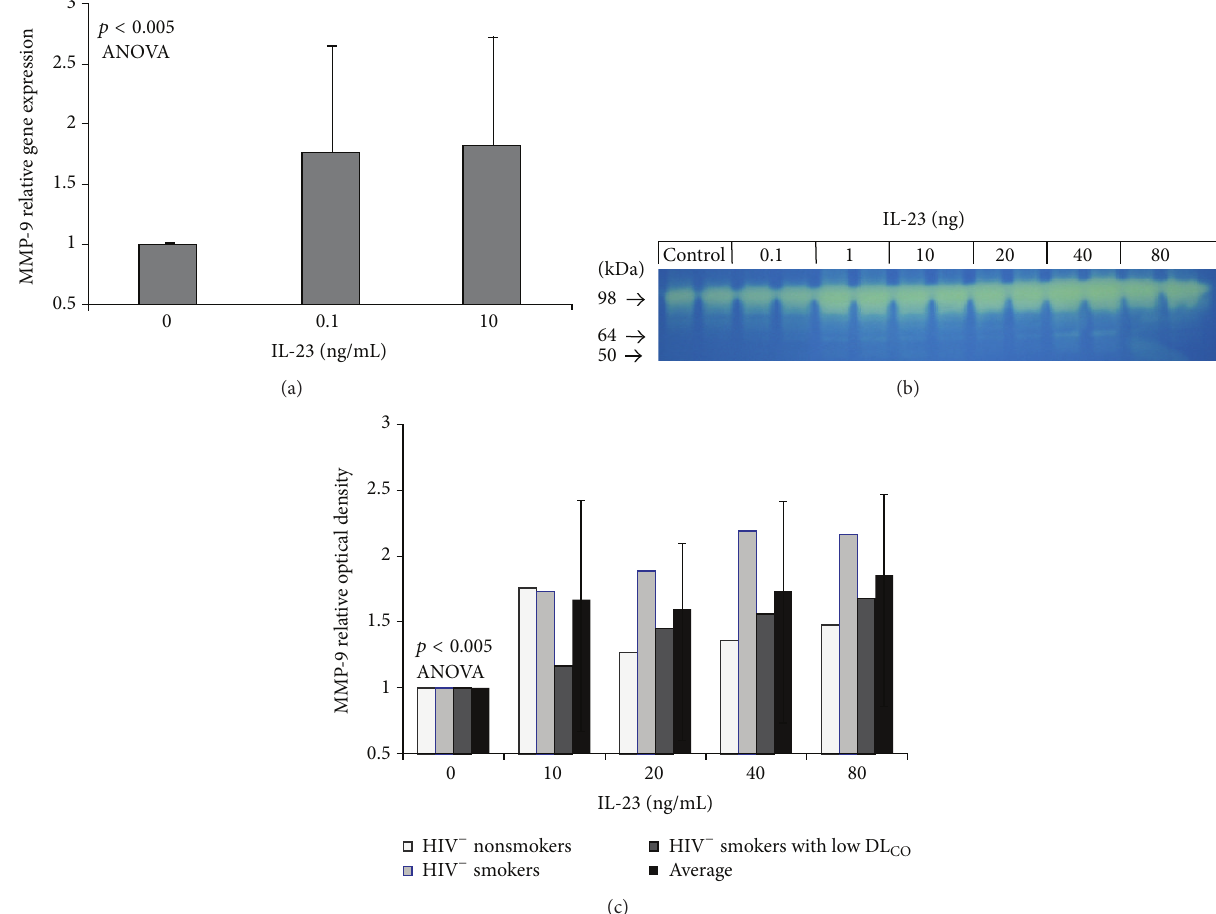
Figure4:EffectofIL-23onMMP-9expressioninAM/lymphocytecoculture.(a)EffectofIL-23(0.1–10 ng/mL)onAM/lymphocytecocultures ( 𝑛 = 13 ) relative MMP-9 gene expression (mean ± SEM, 𝑝 < 0.005 , ANOVA). (b) Gelatin zymography analysis of MMP-9 activity in conditioned media of HIV1 − healthy smoker AM/lymphocyte cocultures stimulated with IL-23. Shown is a representative gel. Lanes 1, 2: control; lanes 3, 4: IL-23, 0.1ng/mL; lanes 5, 6: 1ng/mL; lanes 7, 8: 10 ng/mL; lanes 9, 10: 20 ng/mL; lanes 11, 12: 40 ng/mL; and lanes 13, 14: 80 ng/mL. (c) Quantitation of gelatin zymography analysis of MMP-9 activity in conditioned media from 10 HIV1 − nonsmokers ( 𝑛 = 10